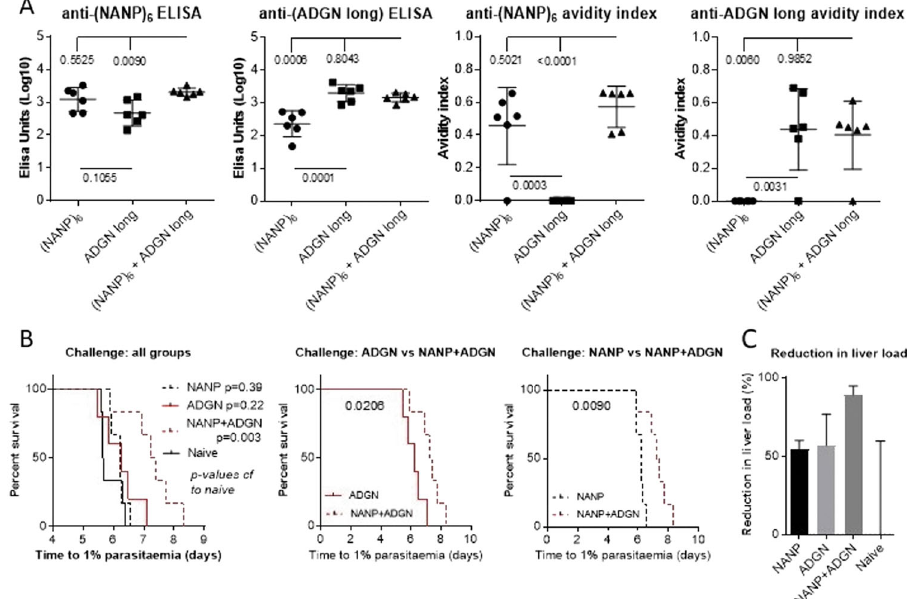
Fig. 3 Effects on immunogenicity and protective ef fi cacy of combining Q β -(NANP) 6 and Q β -(ADGN long) vaccines. BALB/c mice ( n = 6 per group) were vaccinated with two shots by intramuscular injection of 1 µg of each Q β -peptide in Matrix-M ™ adjuvant into separate legs using a 3-week prime-boost interval. A Standard curve ELISAs from sera taken 2 weeks post-boost, and avidity. Numbers represent p values from ANOVA with Bonferroni ’ s multiple comparisons test. B Mice were challenged 3 weeks post-boost by intravenous injection of 1000 PfCSP replacement P. berghei sporozoites into the tail vein. The time to reach 1% blood-stage parasitaemia was calculated by linear regression from daily thin blood smears. Numbers represent p-values from log-rank tests between indicated groups. Means are shown ± SD. C Reduction in liver load, the ratio of infected hepatocytes in vaccinated ( L V ) compared to naïve mice ( L N ), was calculated using the formula Reduction (%) = (1 − i V )*100, where the vaccine-reduced infectivity i V = L V / L N = g Tn − Tv , where g is the blood-stage growth rate, T N the median time-to-1% in naïve mice, and